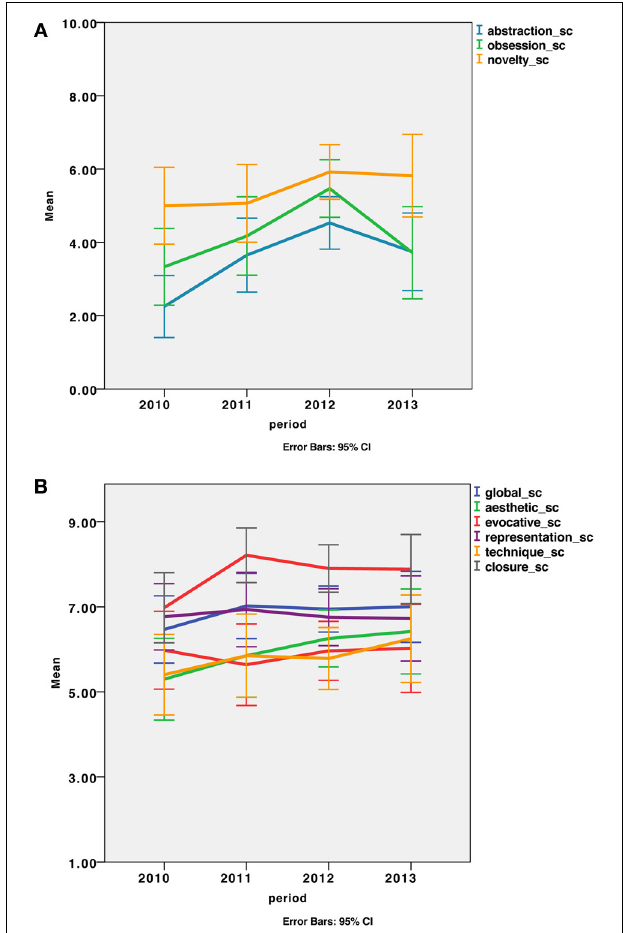
FIGURE 3 | Scores of the drawings across a 36-month period. (A) Subscores with a significant improvement between the first (2010–2011) and the second period (2012–2013) of the drawings. Significant increases were observed for the abstraction, obsession and novelty subscores. (B) The global score and several subscores did not show a significant improvement between the first and the second period, though all scores increased.